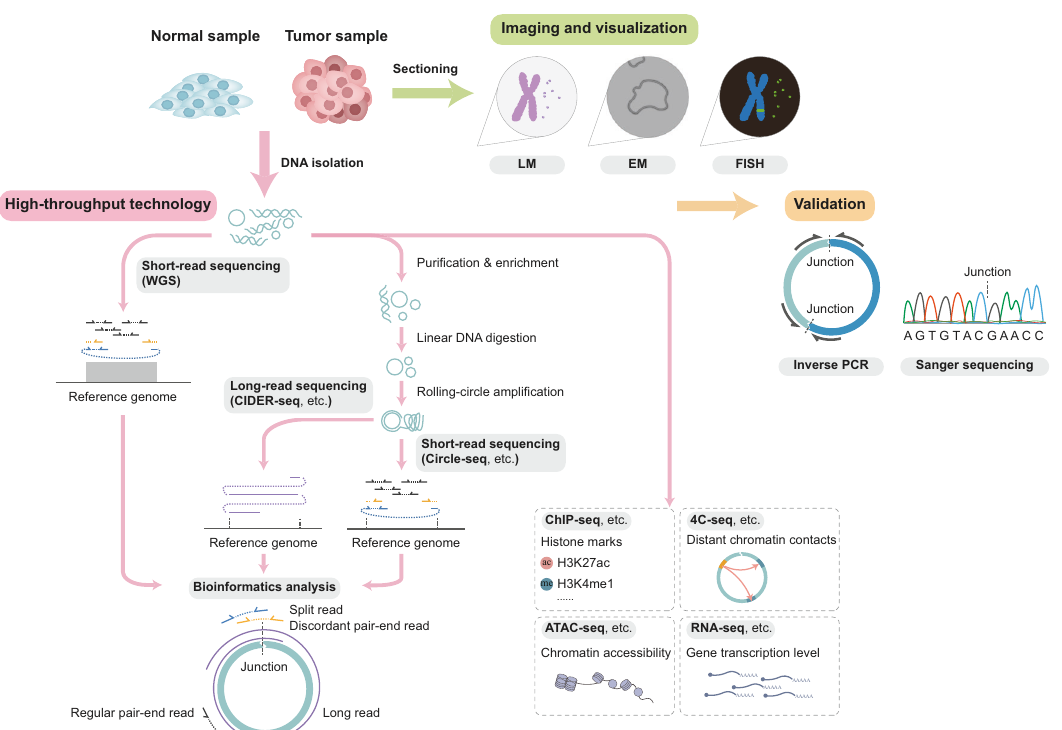
Fig. 6 Tools and methods in the exploration of eccDNA. High-throughput technologies have been applied to detect the existence and structure of eccDNA. EccDNAs can be reconstructed by analyzing data from short-read sequencing, including whole-genome sequencing and Circle-seq, along with long-read sequencing by a bioinformatics algorithm. Other epigenetic techniques, such as ChIP-seq, ATAC-seq, and 4C- seq, assist in the exploration of the topological structure. Notably, inverse PCR and Sanger sequencing have been applied in the validation of eccDNA. Light microscopy (LM), electron microscopy (EM), and fl uorescence microscopy are involved in the visualization of eccDNA and relevant genetic ampli fi